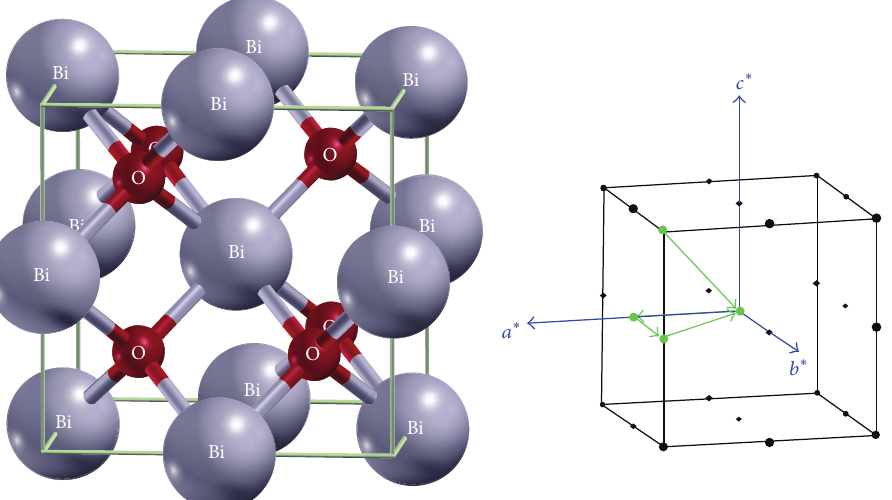
Figure 1: Unit cell for 𝛿 -Bi 2 O 3 , with distinct atomic species explicitly indicated. In the inset we show the associated Brillouin zone and the followed path in the energy bands